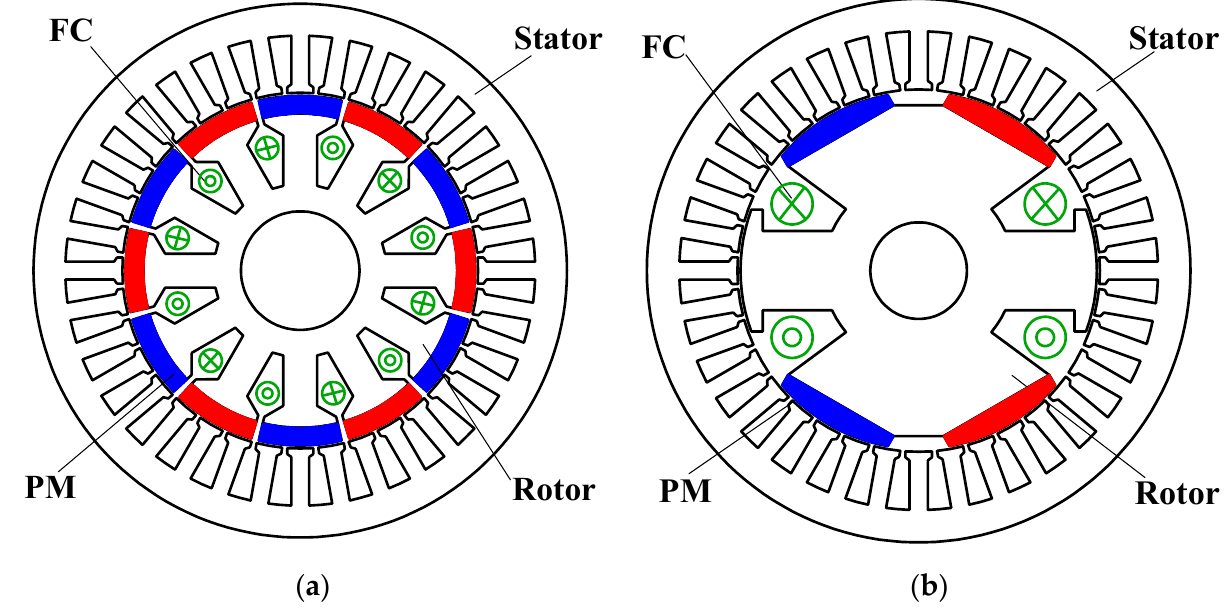
Figure 2. Cross sections of rotor ‐ excited HE machines. ( a ) Rotor ‐ excited HE machines with series coupling [17]. ( b ) Rotor ‐ excited HE machines with parallel coupling [20].